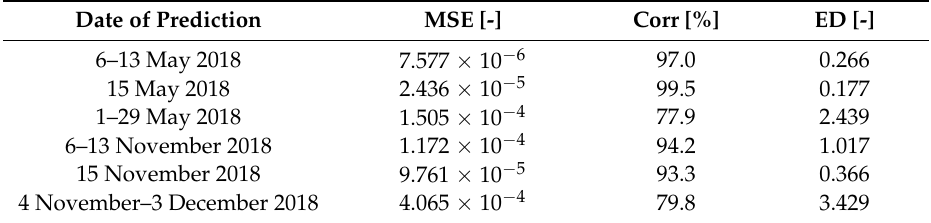
Table 10. The summarization of the evaluation parameters of the original CO 2 prediction.